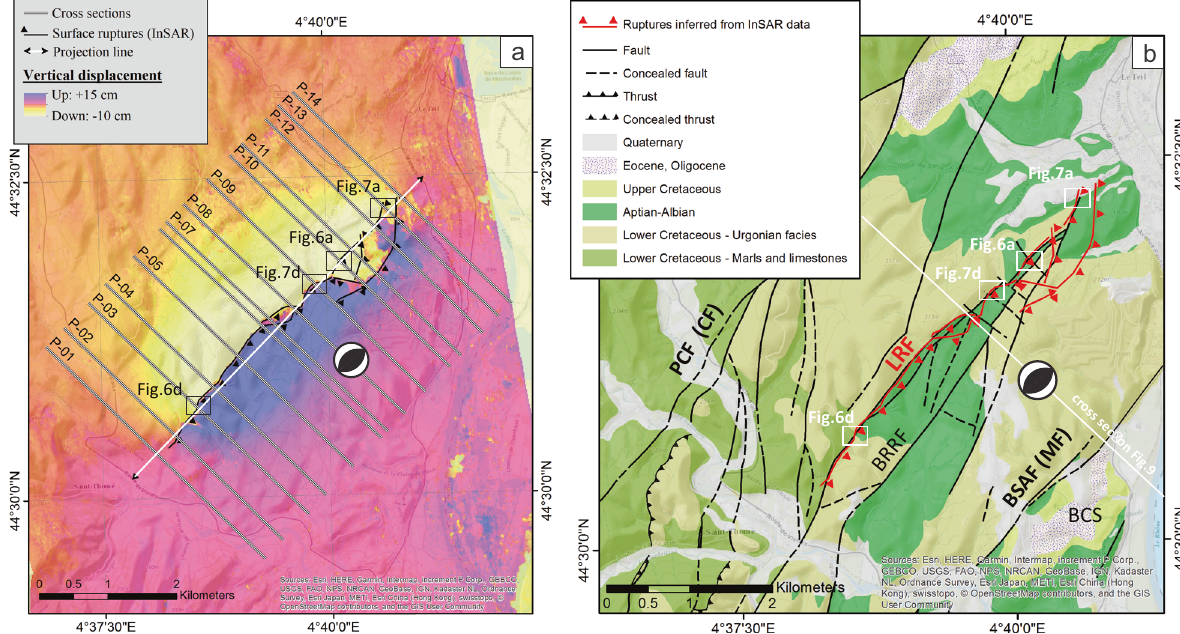
Fig. 4 Map of vertical displacements from InSAR data and map of the main geological formations in the region affected by the Teil earthquake. a Vertical displacement associated to the 11 November 2019, M w 4.9 Le Teil earthquake inferred from the unwrapped InSAR interferogram (ascending track) draped over a satellite image of the area; maximum gradient on this map allows tracing the surface rupture; the epicenter of the event is represented by its focal mechanism; thin black lines correspond to extracted pro fi les across the rupture to determine the vertical displacement and the width of the deformation zone. b Simpli fi ed geological map (modi fi ed from BRGM) of the Le Teil region highlighting the sharp correspondence between the co-seismic rupture trace inferred from InSAR (in red) and the La Rouvière Fault in black. PCF (CF) Pontet-de-Couloubre Fault (Cevennes Fault), LRF La Rouvière Fault, BRRF Bayne-Roche-Renard Fault, BSAF (MF) Bayne-Saint-Alban Fault (Marsanne Fault), BCS Bayne-Couijanet